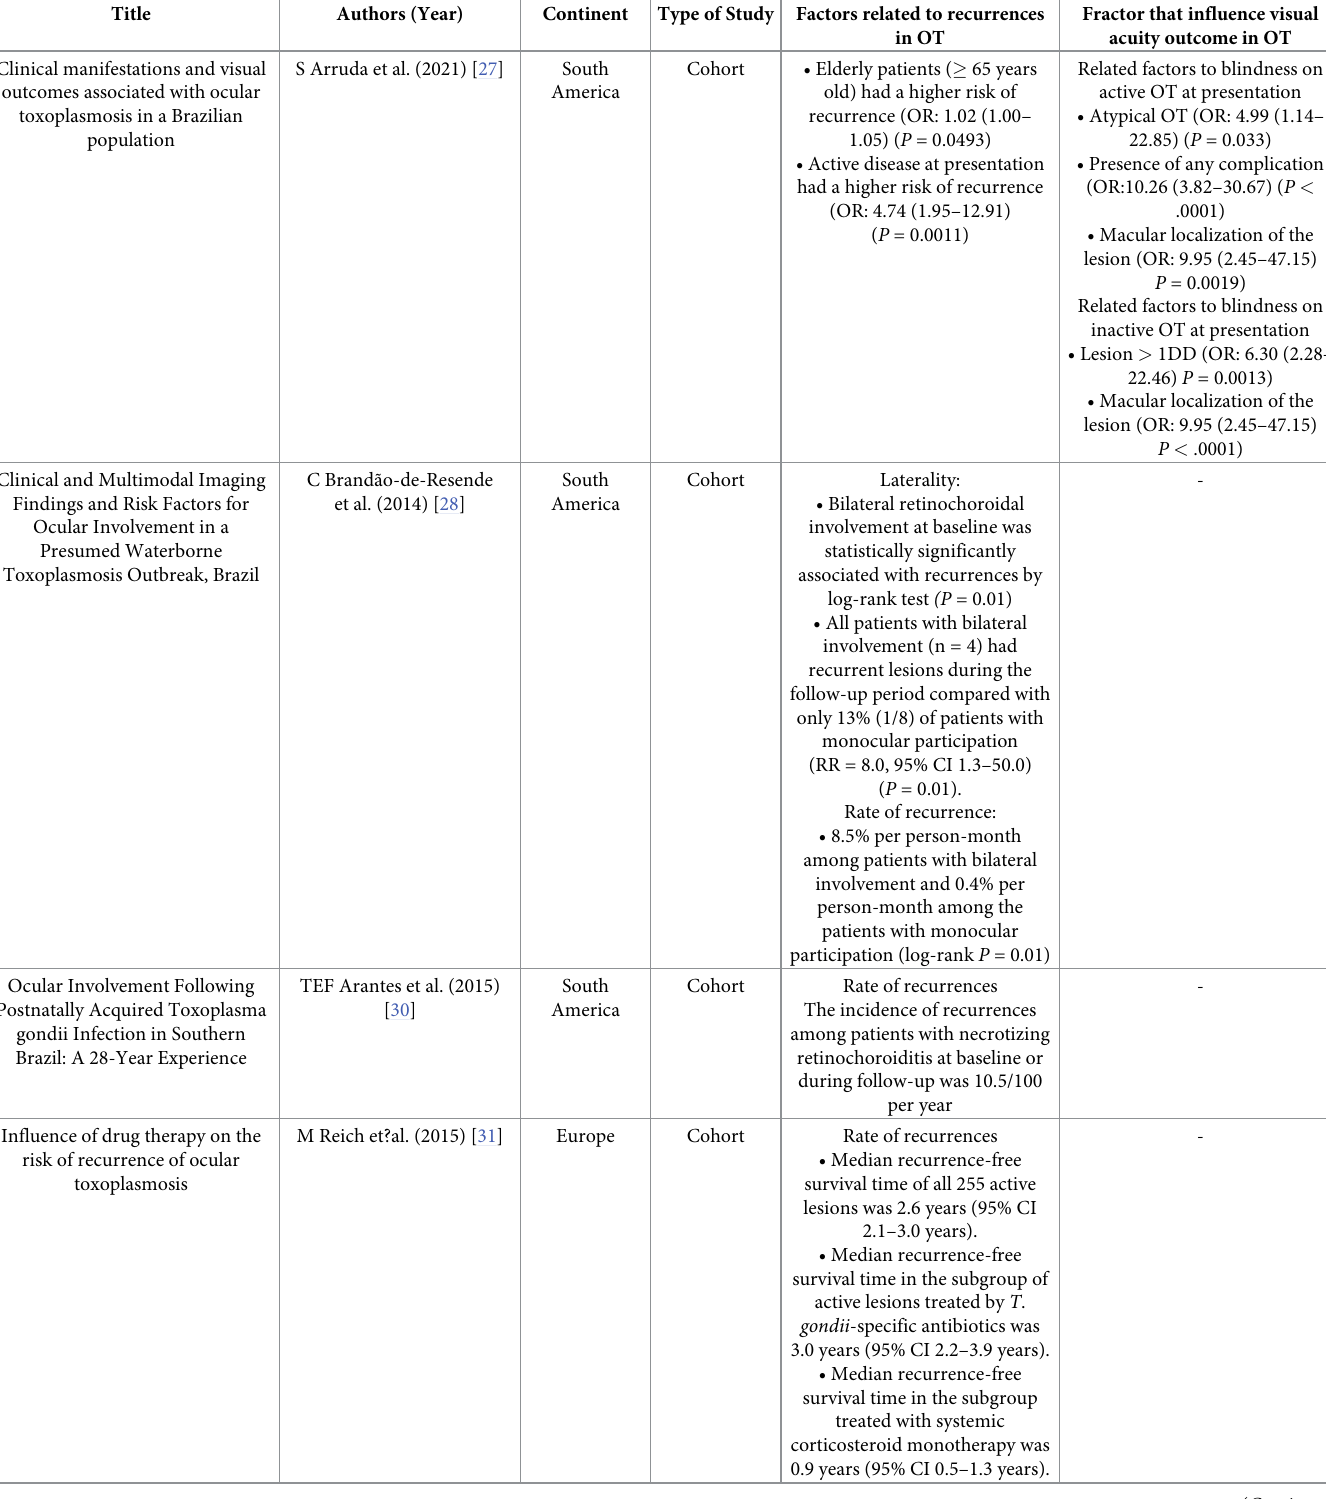
Table 1. Clinical and environmental